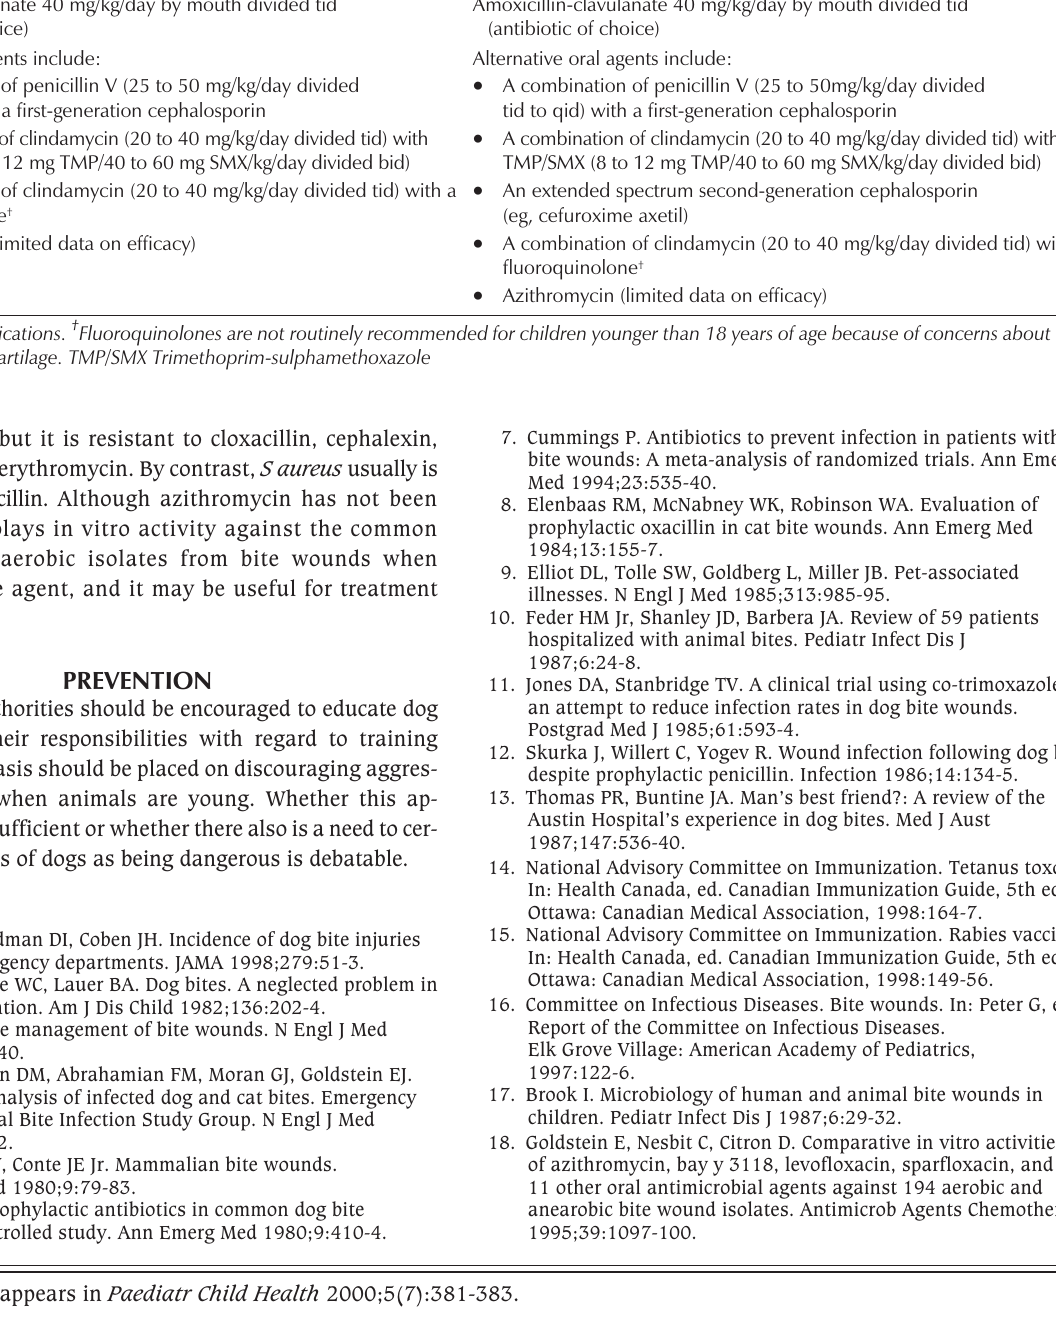
Prophylaxis (duration of 48 to 72 h) or empirical oral therapy for established infections caused by dog and cat bites* Dog bites Cat bites Amoxicillin-clavulanate 40 mg/kg/day by mouth divided tid (antibiotic of choice) Alternative oral agents include: (cid:1) A combination of penicillin V (25 to 50 mg/kg/day